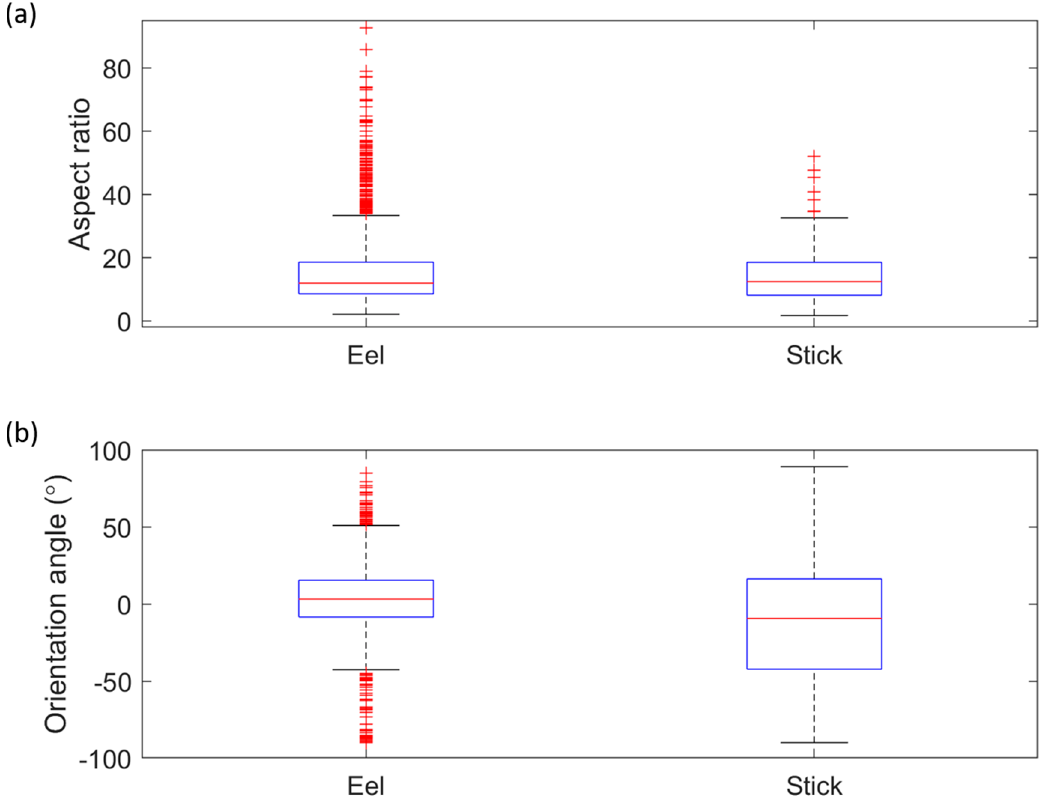
Figure 6. The aspect ratio ( a ) and orientation angle ( b ) of eel and stick in the laboratory experiments.